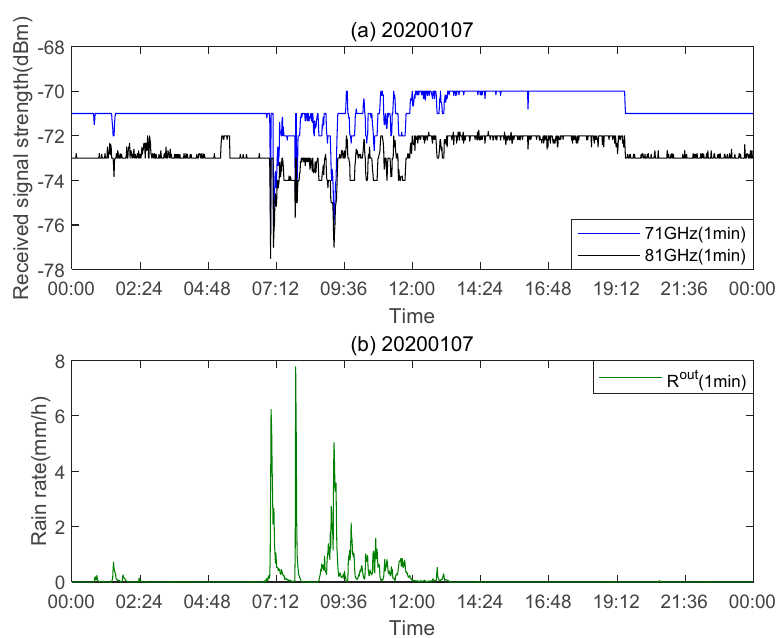
Figure 3. ( a ) The received signal intensity on 7 January 2020; ( b ) the rainfall rate output by the raindrop spectrometer.